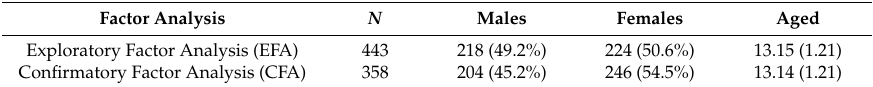
Table 2. Sample distribution for factor